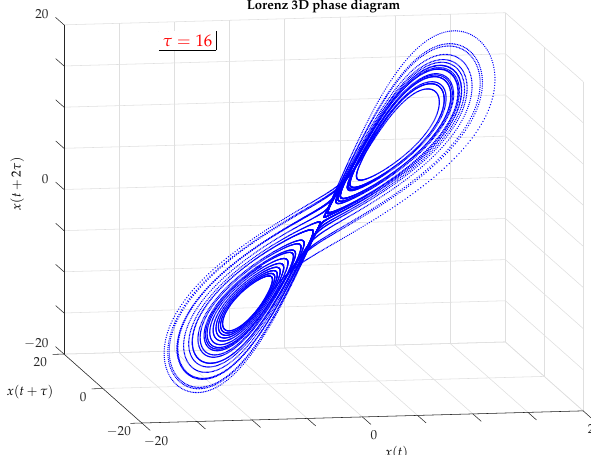
Figure 5. State space reconstruction from the dynamic variable x of the Lorenz attractor, with a sampling time ∆ t of 2 ms: ( a ) with τ = 1; and ( b ) with τ = 150.